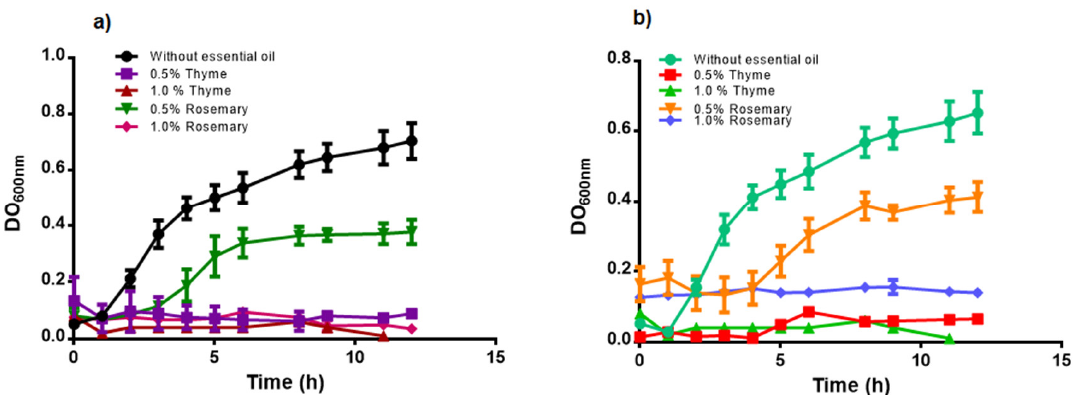
Figure 1. Free essential oils antimicrobial effect on ( a ) Micrococcus luteus ; ( b ) Salmonella sp .